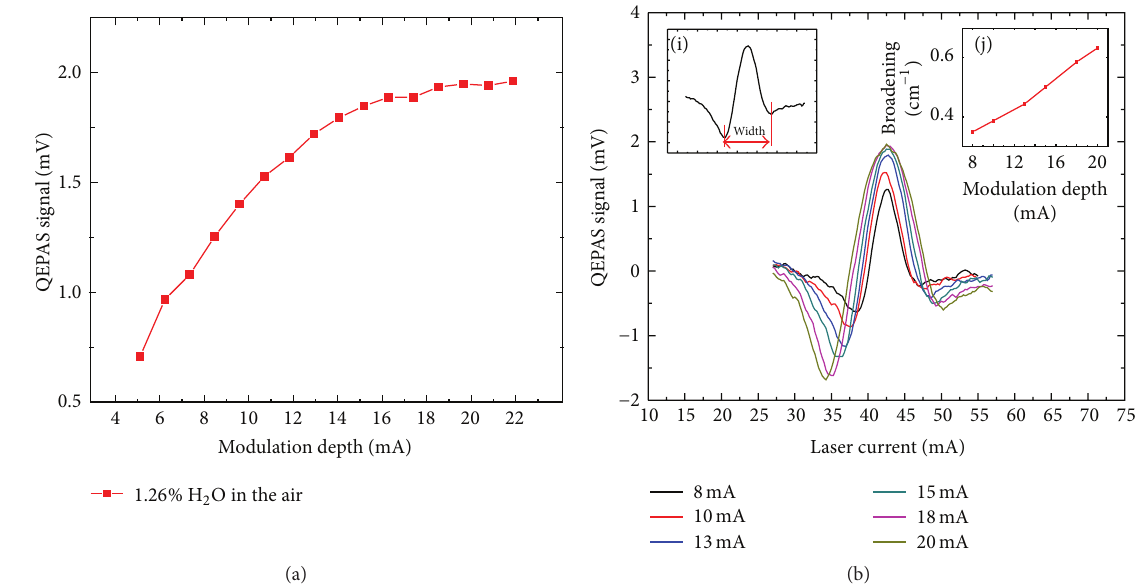
Figure 7: (a) QEPAS signal amplitudes as a function of laser modulation depth; (b) spectral broadening widths of QEPAS signal as a function of laser modulation depth.